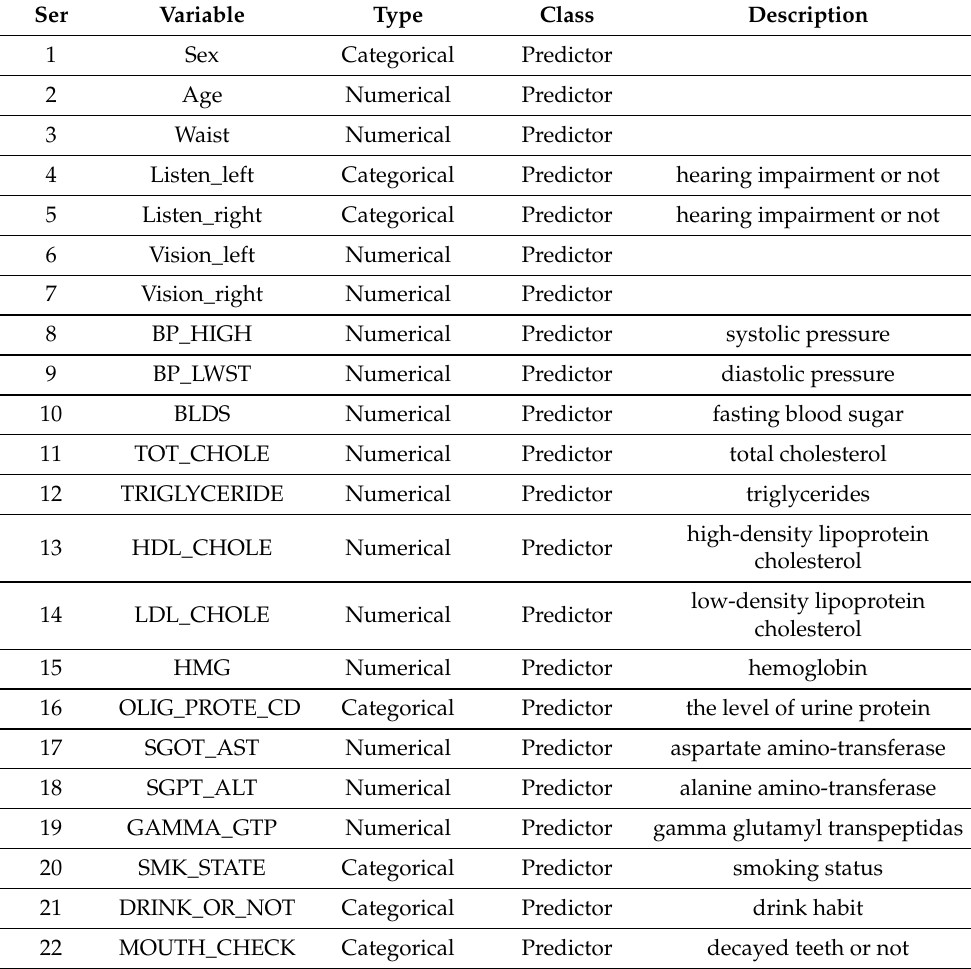
Table 1. Description of variables used in the